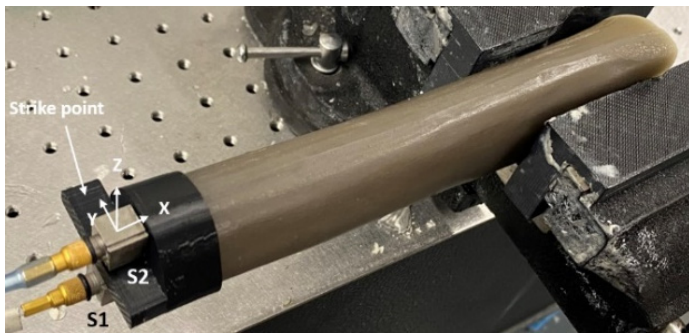
Figure 5. Image of experimental setup with the orientation of sensors.